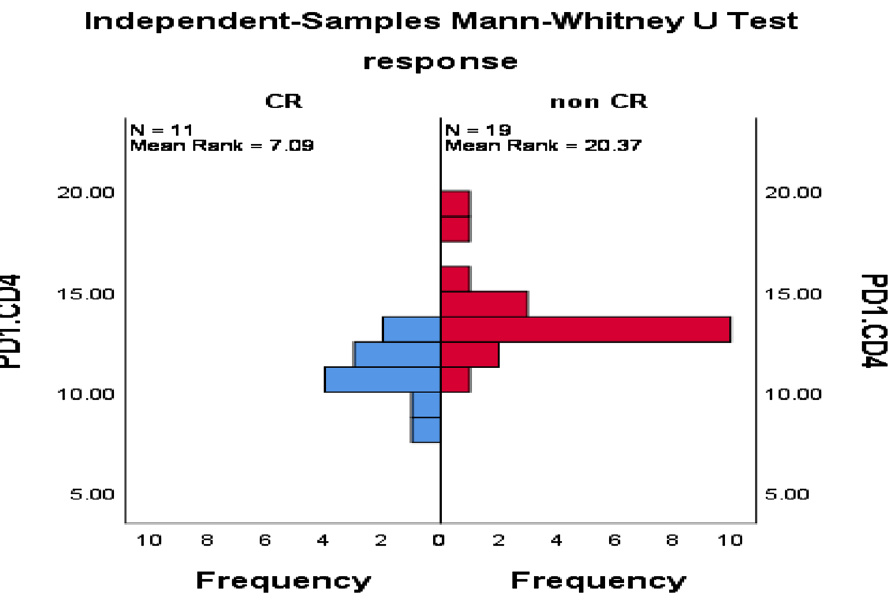
Figure 5. Significant difference between MM patients with CR and those without CR regarding PD1+CD4+T cells, P <